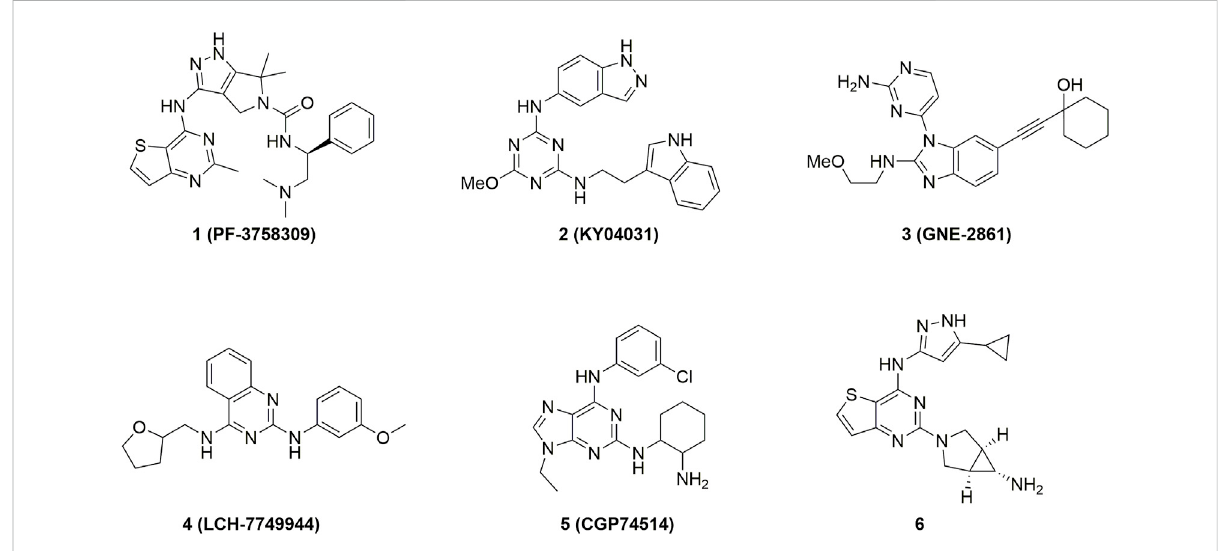
FIGURE 1 Representative PAK4 inhibitors developed before